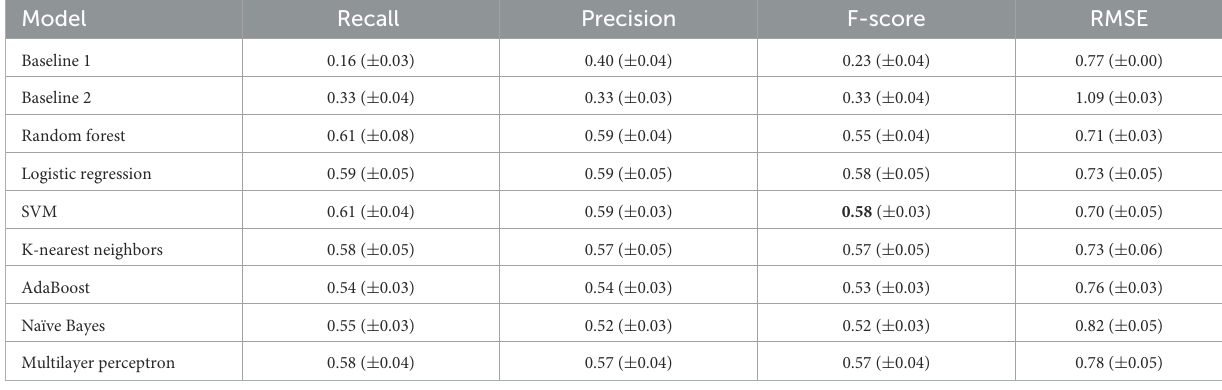
TABLE 4 Results of 3-class engagement level classification (standard deviation in parentheses).